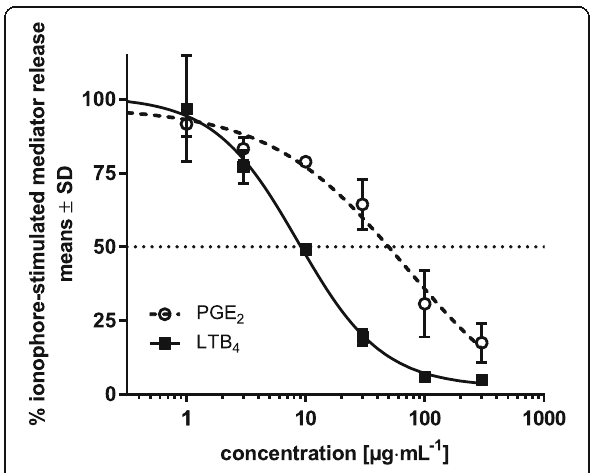
Fig. 2 Ca 2+ -ionophore-stimulated release of the eicosanoids PGE 2 and LTB 4 in whole blood obtained from Wistar rats in the presence of increasing concentrations of BRO. Data shown are means ± SD; n =2 (duplicates in the same experiment)